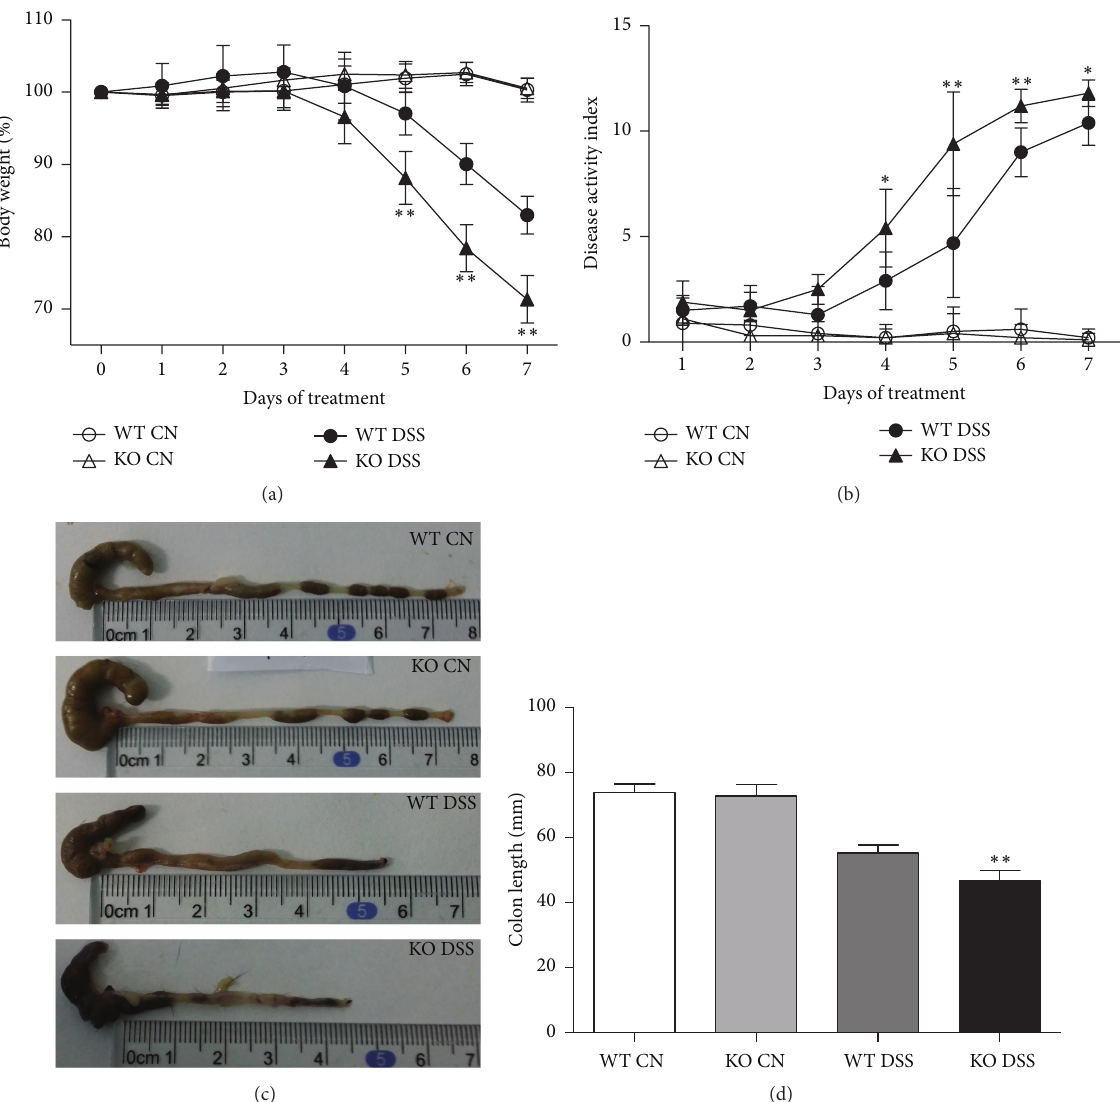
Figure 1: TRAF5-deficient mice are more susceptible to DSS induction. (a) Change in percent body weight. (b) Change in DAI scores. ((c) and (d)) Mice were sacrificed on day 7, and their colons were removed, photographed, and measured in terms of length. The data are presented as the mean ± SD. 𝑁 = 10 per group. ∗ 𝑝 < 0.05 versus the DSS-treated WT group and ∗∗ 𝑝 < 0.01 versus the DSS-treated WT